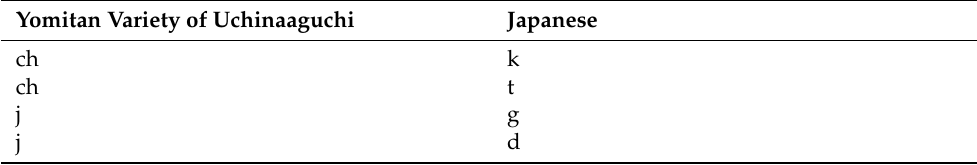
Table 4. Palatalization and phonological correspondences.